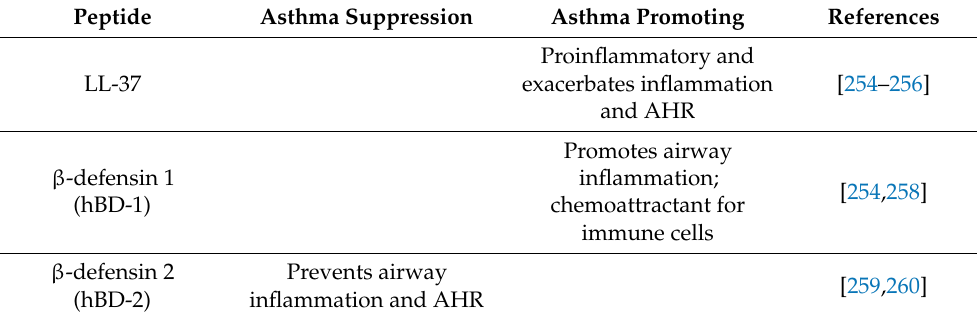
Table 5. Description of the effect of antimicrobial peptides on asthma pathology.